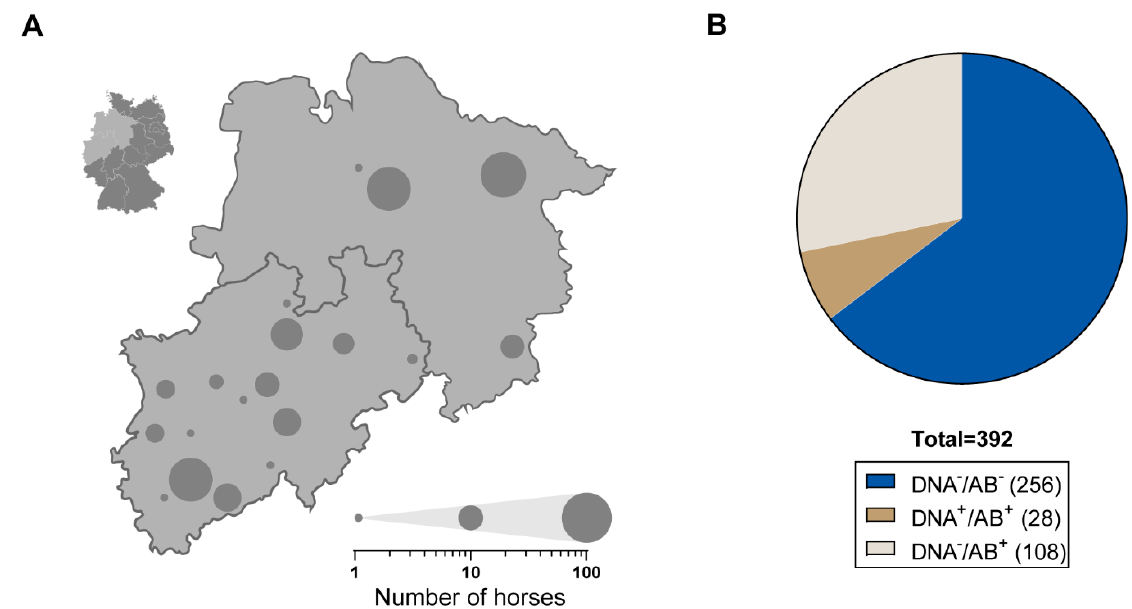
Figure 1. ( A ) Map of Germany highlighting the location of sampling (insert upper left). Serum samples were collected from 392 Thoroughbreds in North Rhine-Westphalia and Lower Saxony. Grey circles highlight the sample location and circle size is scaled to relative the number of examined horses (see legend lower right). ( B ) Serum samples were analysed for the presence of anti-equine parvovirus-hepatitis (anti-EqPV-H) VP1 AB and EqPV-H DNA performing luciferase immunoprecipitation system (LIPS) and qPCR, respectively. Individual horses were assigned to three different groups: Seronegative and EqPV-H DNA negative (DNA − / AB − ; 65.3%), seropositive and EqPV-H DNA negative (DNA − / AB + ; 27.55%), and seropositive and EqPV-H DNA positive (DNA + /AB + ; 7.14%).